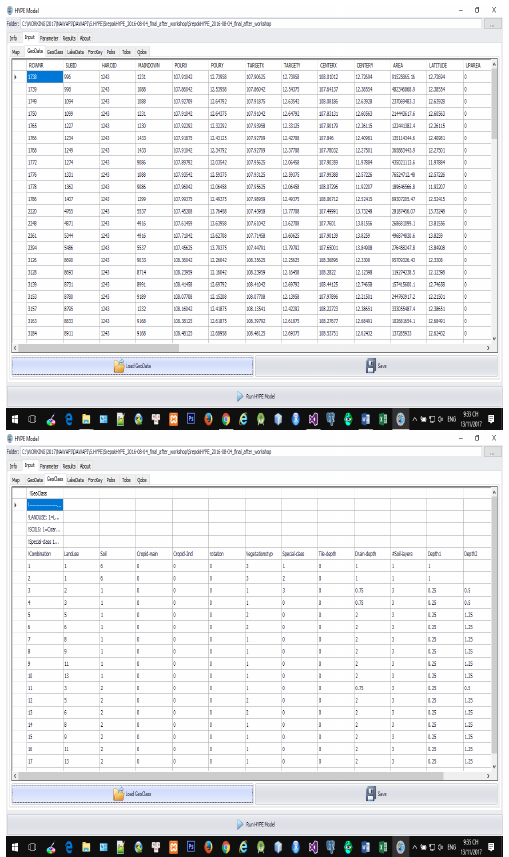
Fig. 6: The interface of GeoData and GeoClass